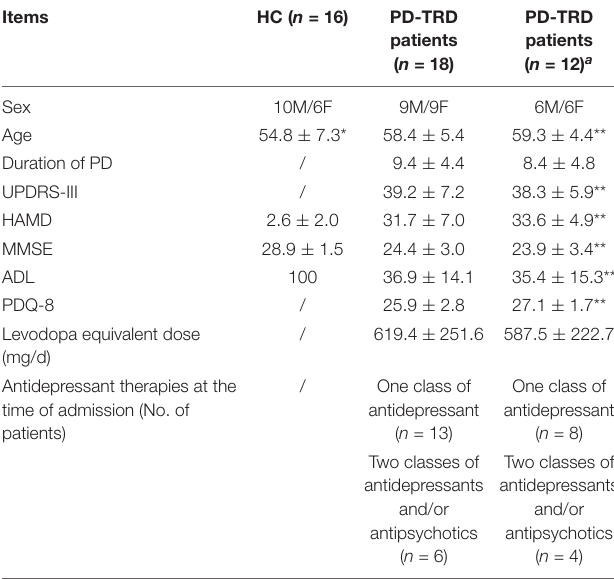
TABLE 1 | Demographics of HC and PD-TRD patients at